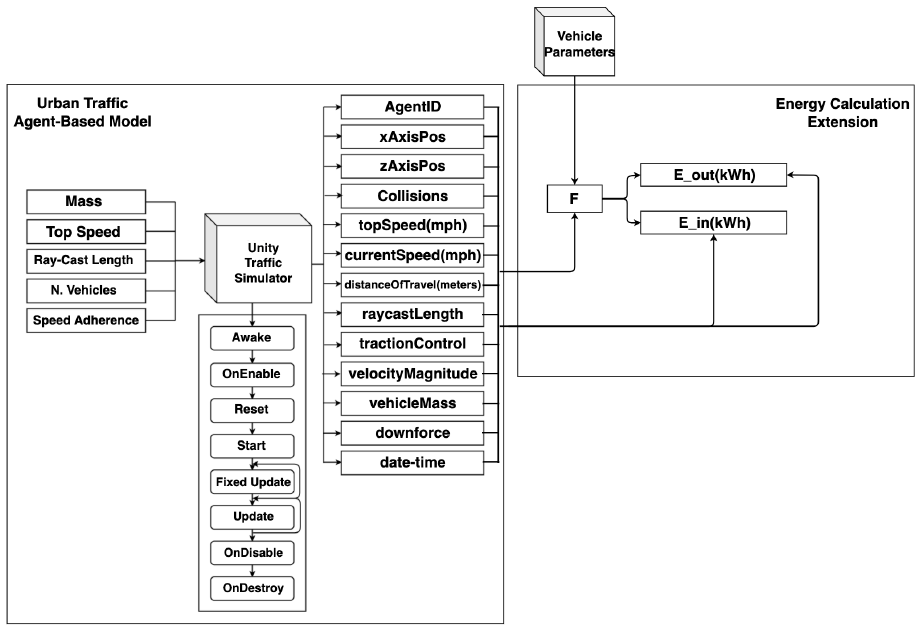
Figure 1. Workflow diagram depicting processes the UTS undergoes during run-time including the Energy Calculation